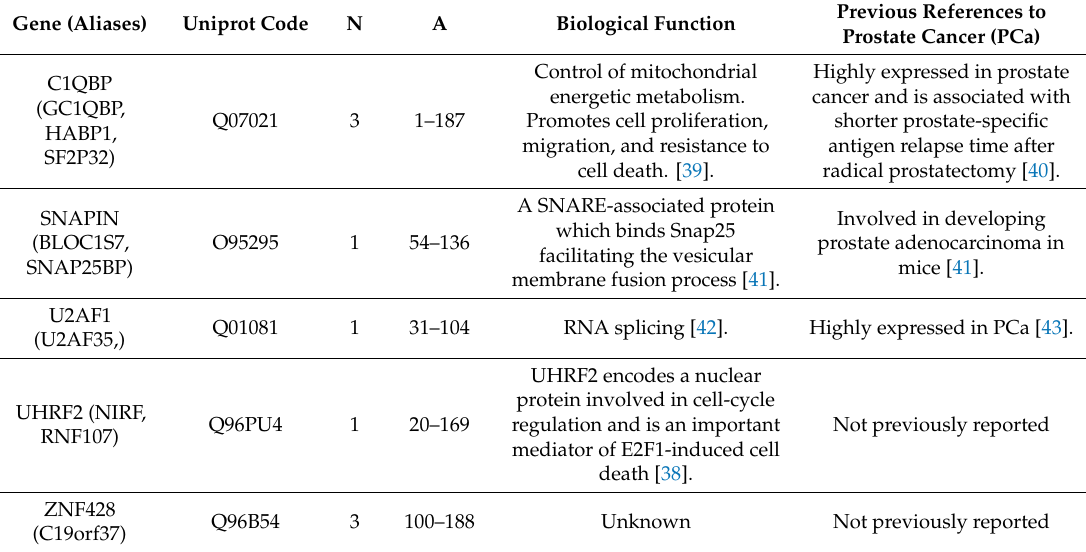
Table 2. Proteins identified in the the high mobility group box B 2 (HMGB2) Y2H interactome in PC-3